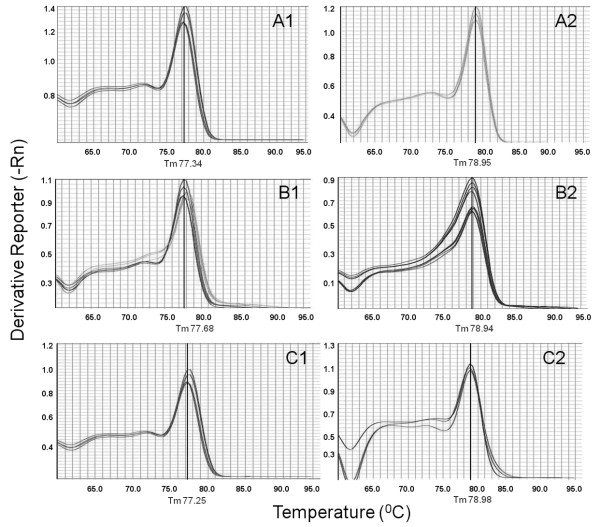
Melting curve analyses of kDNA conserved regions amplicons. Representative SYBR Green dissociation curves of kDNA amplified products to determinate the melting temperature values [Tm]. Following amplification in the ABI Prism 7500 Sequence Detection System, the amplicons were submitted to a gradual temperature increase (0.1°C/s to 90°C). The Tm calculation of each amplicon was done directly by the software provided (indicated by the perpendicular line in the graphics). Each trace in the charts represents a single analyzed DNA sample. The graphics on the left represent typical kinetic dissociation profiles obtained for the Viannia subgenus: (A1) L. (V.) shawi and L. (V.) braziliensis promastigote reference strains; (B1) clinical samples from cutaneous disease patients; (C1) Lu. intermedia and Lu. migonei pools naturally infected by L. (V.) braziliensis. On the right are represented the melting profiles for the subgenus Leishmania: (A2) L. (L.) amazonensis and L. (L.) infantum promastigote reference strains; (B2) clinical specimens from visceral disease patients; (C2) Lu. cruzi and Lu. forattinii pools naturally infected by L. (L.) infantum.